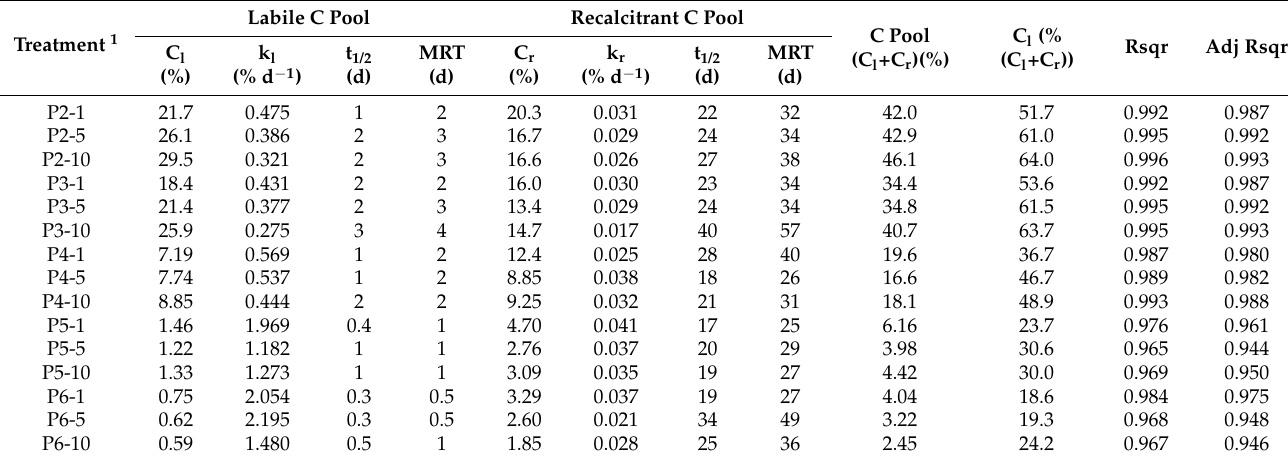
Table 3. Model parameters and coefficients of determination (r 2 ) estimated using the double exponential model fitted to the applied C mineralized (ACM) data from the different